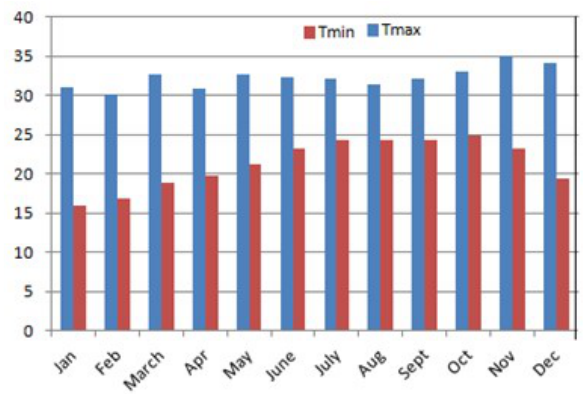
Figure 6: Annual variation of ambient maximal and 2013, 2014 and